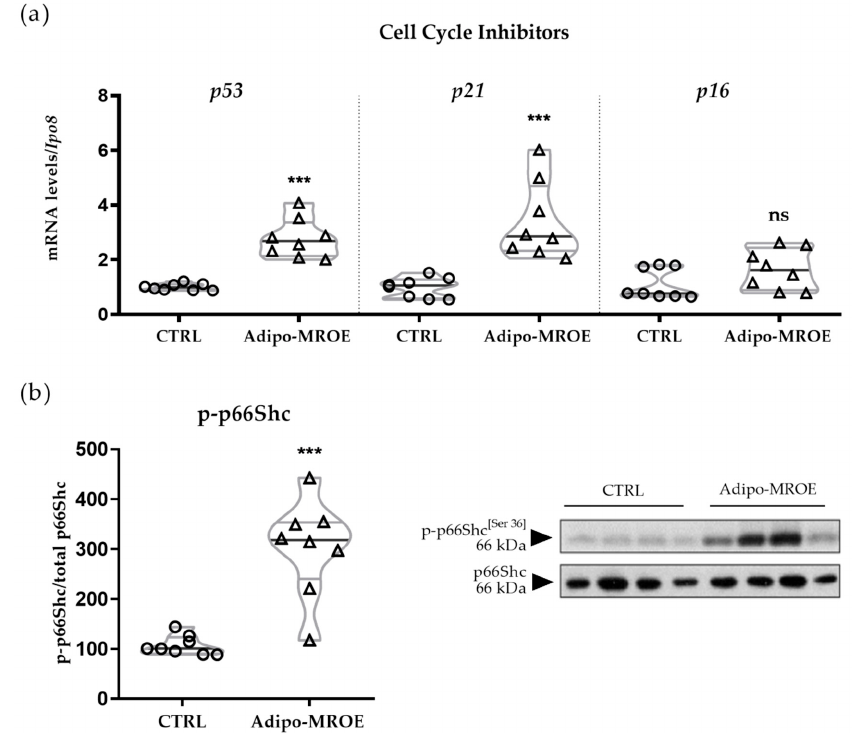
Figure 6. Cellular senescence and OS induced apoptotic pathways are induced in the EVAT of adipocyte-MR overexpressing mice. ( a ) p53 and p21 mRNA levels as assessed by qRT-PCR are increased in the EVAT of Adipo-MROE mice, while p16 mRNA levels are unchanged; ( b ) The phosphorylation of the P21 target p66SHC is increased in the EVAT of Adipo-MROE mice, indicating cellular response to OS. Data are expressed as violin plots with quartiles and individual dots. n = 8 mice per group; *** p < 0.001; ns = not significant, Adipo-MROE vs. control. Ipo8 : importin 8.